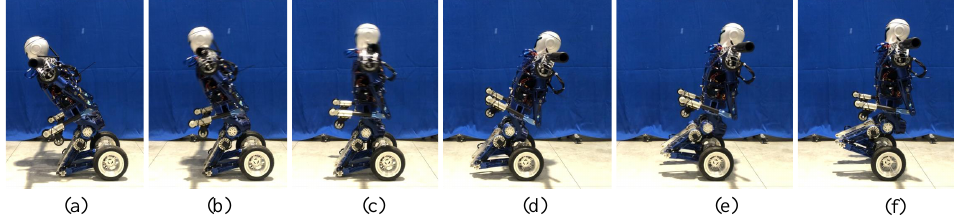
Figure 17. Mode transition experiment from kneeling to balanced standing ( a – f ).